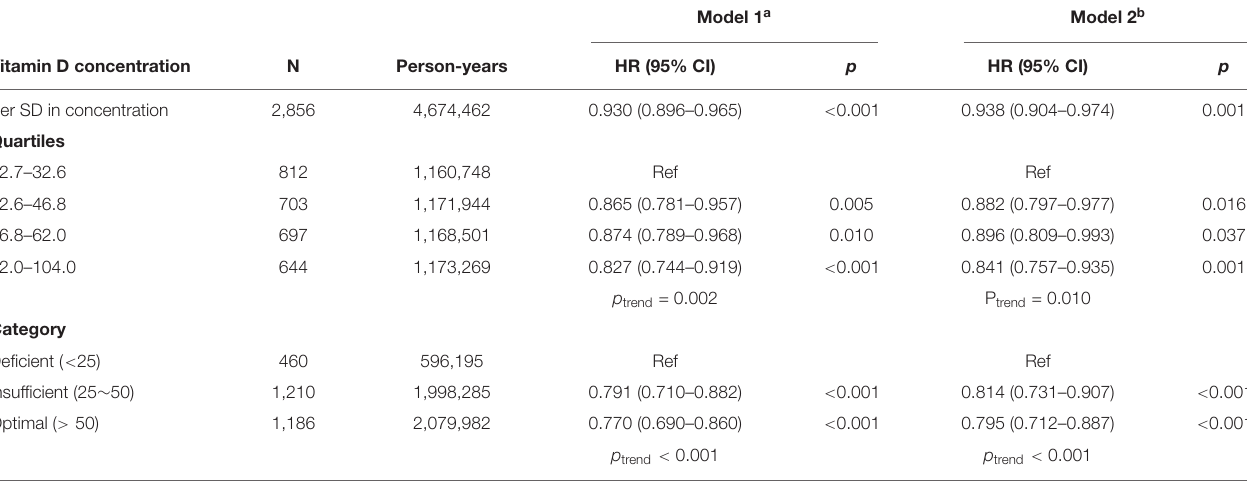
TABLE 2 | Association of vitamin D concentrations with incident